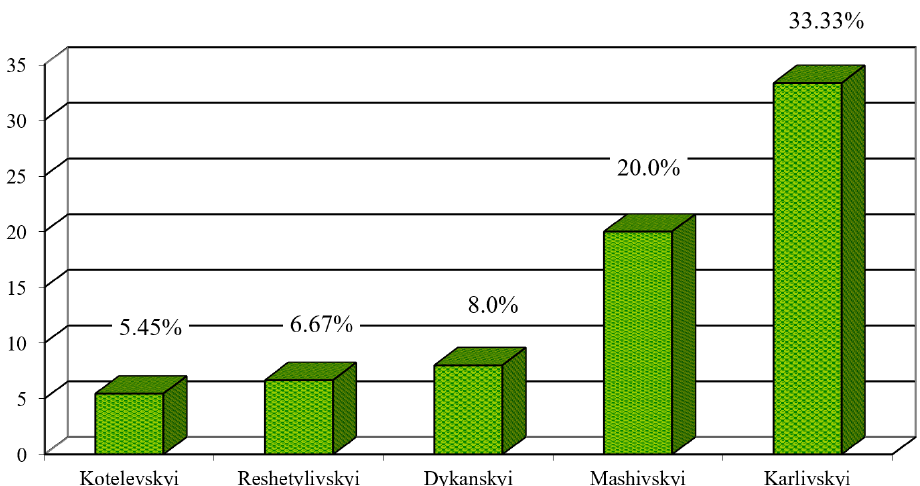
Fig. 7. Indicators of extensiveness of trichurosis infestation of sheep in different districts of Poltava